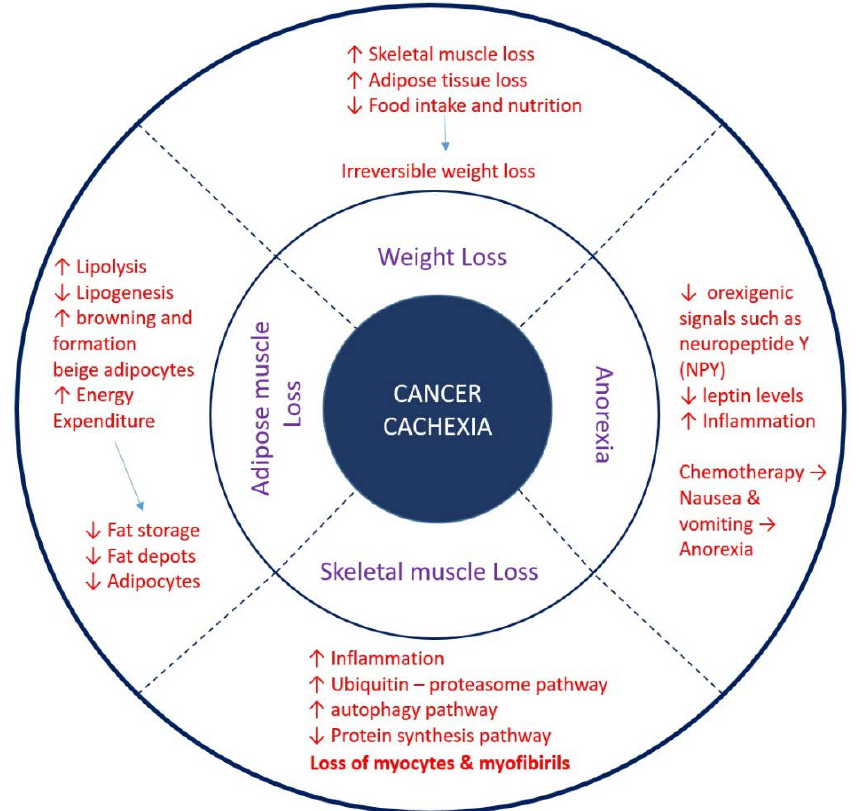
Figure 1. Features of cancer cachexia. Irreversible weight loss, anorexia, skeletal muscle loss, and adipose tissue loss are four cardinal features of cancer cachexia. Loss of adipocyte, skeletal muscle, and anorexia leads to irreversible weight loss in cachectic patients. Change in orexigenic signals, and imbalance in adipokine secretion results in anorexia. Side effects of chemotherapeutic drugs result in vomiting and nausea, leading to a decrease in food intake, while depression, a very common symptom among cancer patients, further promotes a decrease in food intake. Chronic inflammation due to ubiquitin proteasomal and autophagy pathway, and downregulates protein synthesis